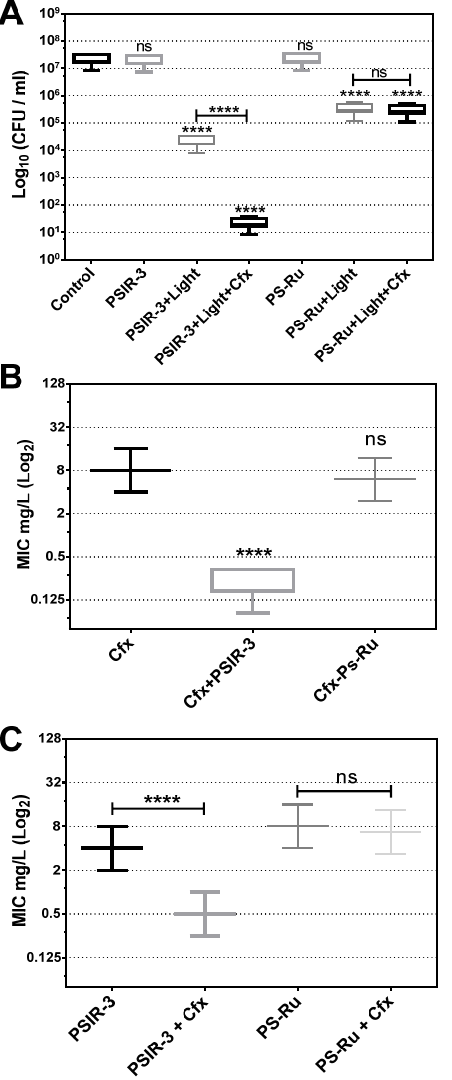
Figure 5. Antimicrobial photodynamic inactivation of clinical isolates of K. pneumoniae . ( A ) Growth inhibition of 118 clinical isolates of K. pneumoniae subjected to antimicrobial photodynamic inactivation (aPDI) with PSIR-3. The bacteria were used at a concentration of 1 × 10 7 CFUs/mL and mixed in triplicate with 4 mg/L of PSIR-3 or PSIR-4 compounds. For the aPDI, the mixture of bacteria with PS was exposed for 1 h at 17 µ W/cm 2 of white light. As a control, bacteria combined with the photosensitizers (PSs) not exposed to light (PSIR-3 or PS-Ru) and bacteria not combined with the PSs (control) were included. Colony count enumerated of viable bacteria on ca-MH agar after serial micro-dilution. The CFUs/mL values are presented as means ± SD on a log 10 scale. ( B ) From the clinical isolates, 66 ESBL-producing bacteria were exposed to aPDI, using PSIR-3 or PS-Ru, and MIC for cefotaxime (Cfx) was performed in triplicate, in ca-MH broth, for 16–20 h. ( C ) For ESBL-producing bacteria, the MIC for PSIR-3 or PS-Ru, were determined in combination with 4 mg/L of Cfx, performed in triplicate in ca-MH agar for 16–20 h. The MIC values are presented as median ± SD of mg/mL on a log 2 scale. Not significant (ns) p > 0.05 by Student’s t -test among treated bacteria compared to control; **** p < 0.0001 by Student’s t -test among treated bacteria compared to